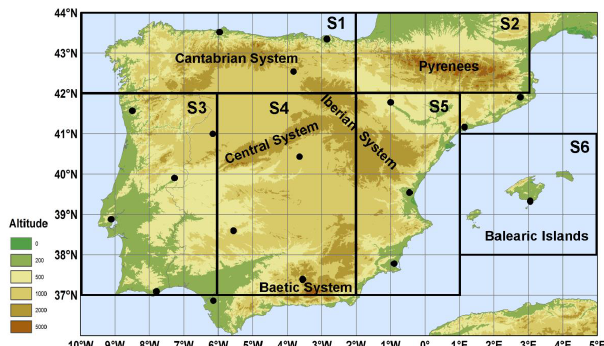
Figure 1: Lightning detection network in the Iberian Peninsula with 14 IMPACT 784 Fig. 1. Lightning detection network in the Iberian Peninsula with sensors in Spain and 4 IMPACT sensors in Portugal. Black circles indicate the 785 14 IMPACT sensors in Spain and 4 IMPACT sensors in Portugal. geographical locations of the 18 sensors. The six selected subsectors (S1-6) in the 786 Black circles indicate the geographical locations of the 18 sensors. The six selected subsectors (S1–6) in the Iberian sector (IS: 36– Iberian Sector (IS: 36-44ºN; 10ºW-5ºE), the orography (altitude in meters) and the main 787 44 ◦ N, 10 ◦ W–5 ◦ E), the orography (altitude in metres) and the main mountain ranges are also depicted. 788 mountain ranges are also